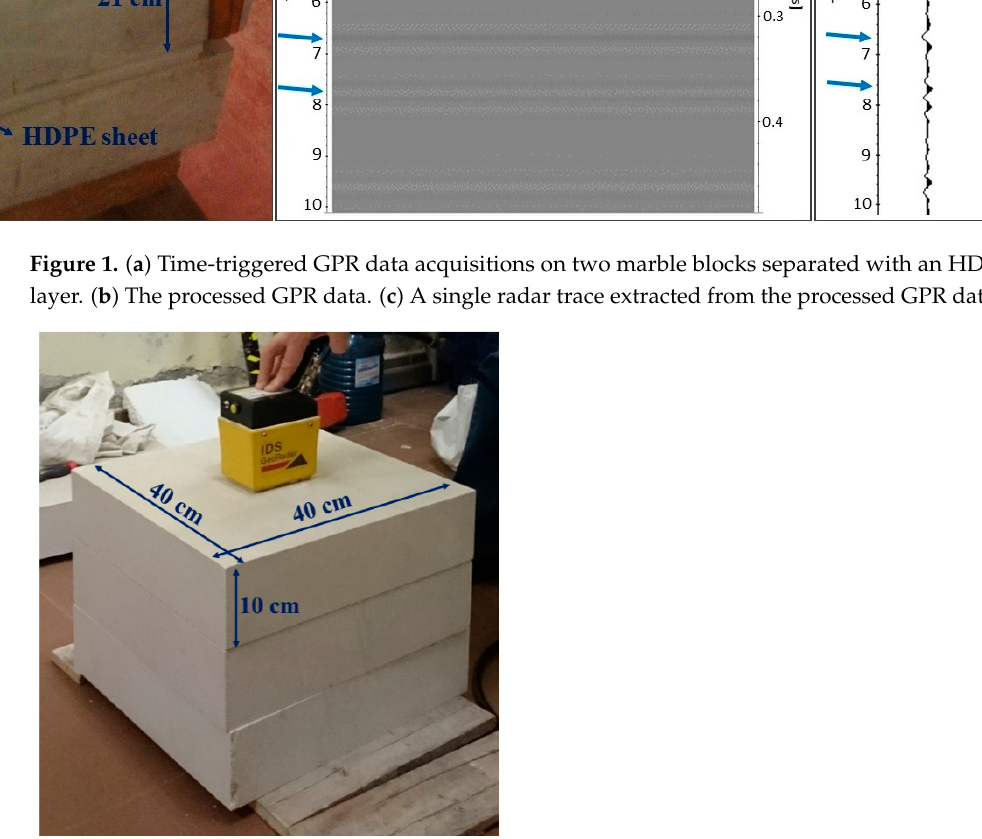
Figure 2. Time-triggered GPR measurements with the antenna fixed in the center of the marble blocks.